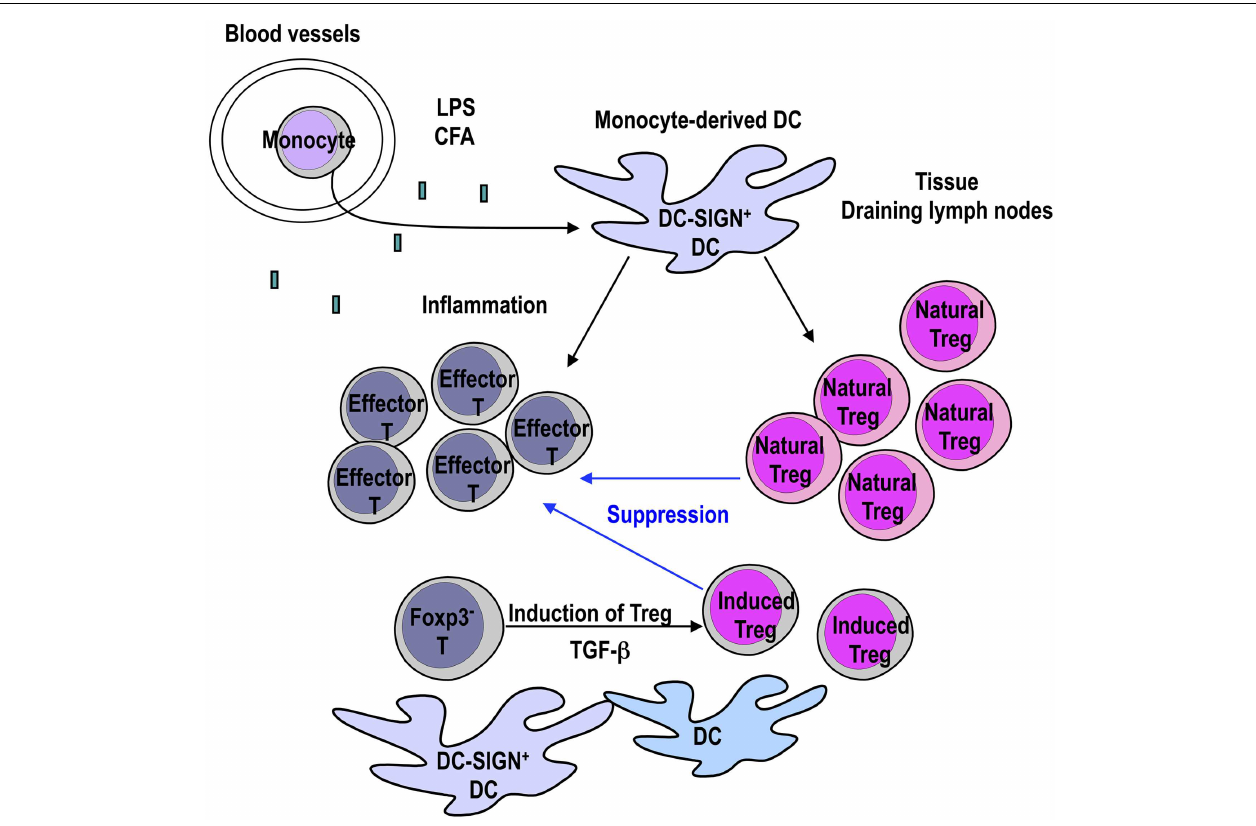
(Yamazaki et al., 2003). IfTGF- β is provided from other cells, mature DCs in the inflammatory site can stimulate the generation of InducedT-regs from Foxp3 − CD4 + T cells in the presence of antigen (Yamazaki et al., 2007). Expanded NaturalT-regs and InducedT-regs may play a role in controlling